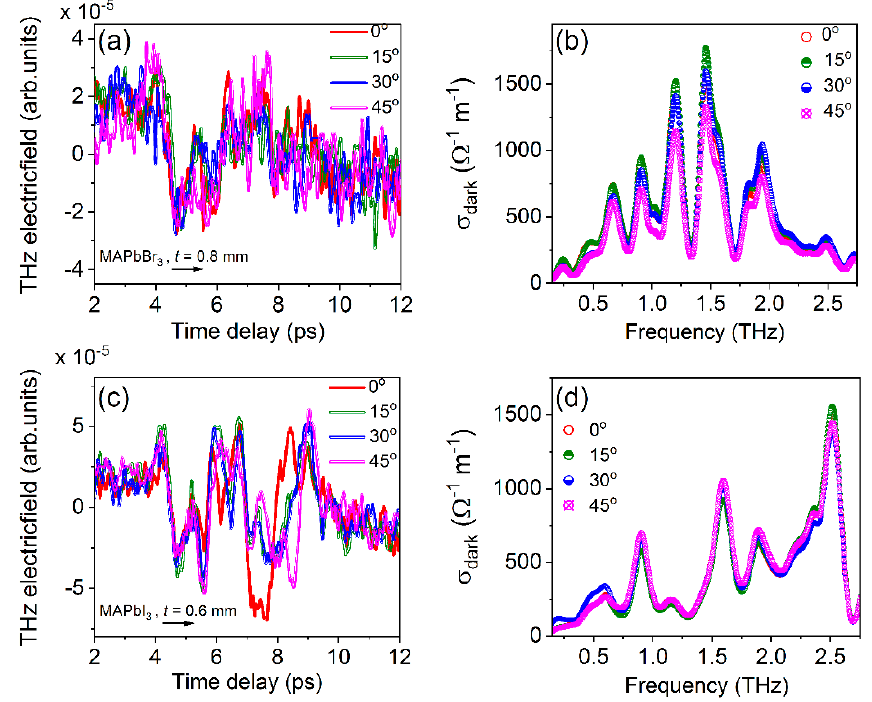
Figure 12. ( a ) THz electric field and ( b ) measured dark conductivity of 0.8 mm thick MAPbBr 3 ; ( c ) ( c ) THz electric field and ( d ) measured dark conductivity of 0.6 mm thick MAPbI 3 for the incidence THz electric field and ( b ) measured dark conductivity of 0.6 mm thick MAPbI 3 for the incidence angle THz pulses between 0 and 45°. angle THz pulses between 0 and 45 ◦